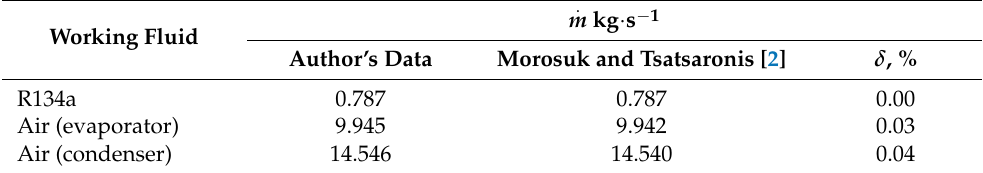
Table 3. Mass flow rates of working fluids for the real cycle with R134a.